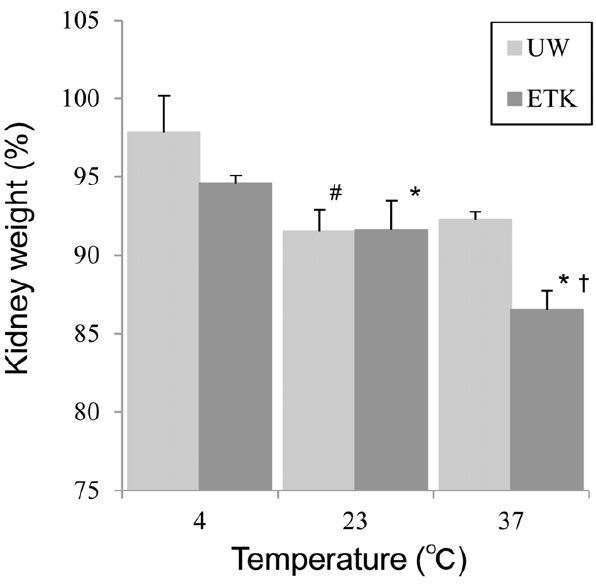
Figure 5. Gravimetric measurements of kidney weights. ETK significantly reduced the kidney weights (KW) with increasing preservation temperature (* ETK at 23 u C vs. ETK at 4 u C, p , 0.05; and ETK at 23 u C vs. ETK at 37 u C, p , 0.001). The prevention of cellular edema with the UW solution was less pronounced as compared to ETK ( # UW at 23 u C vs. UW at 4 u C, p , 0.01; and UW at 23 u C vs. UW at 37 u C, p , 0.05). At 37 u C, the KW of ETK was significantly lower than that of UW ( { p ,